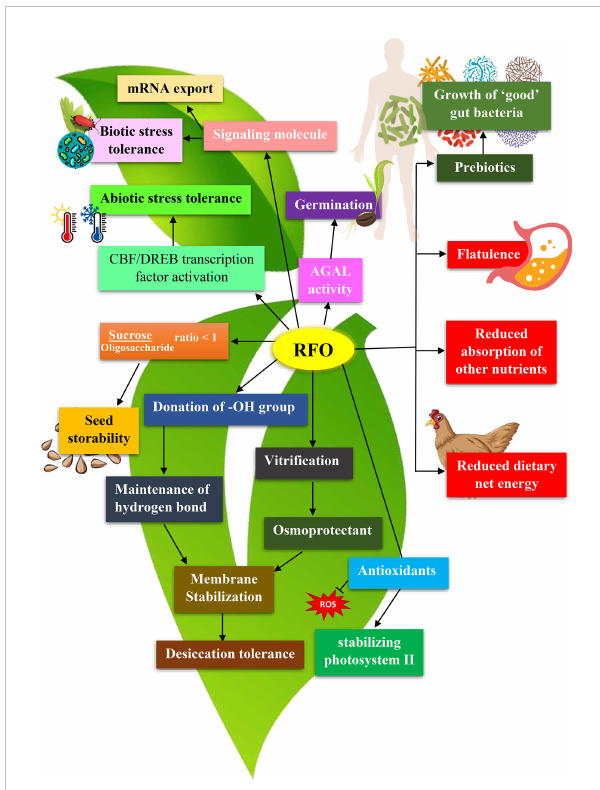
FIGURE 4 Functions of Raf fi nose Family Oligosaccharides (RFOs) in plants and animals. RFOs in plants provide abiotic stress tolerance, serve as a storage compound upon seed germination, maintain osmotic balance, help seed storability, and stabilize membranes. In human and monogastric animals, these same RFOs are responsible for fl atulence production, reduced net dietary energy and decreased absorption of other nutrients. However, when RFOs reach the colon, they serve as prebiotics and help in the growth of probiotic